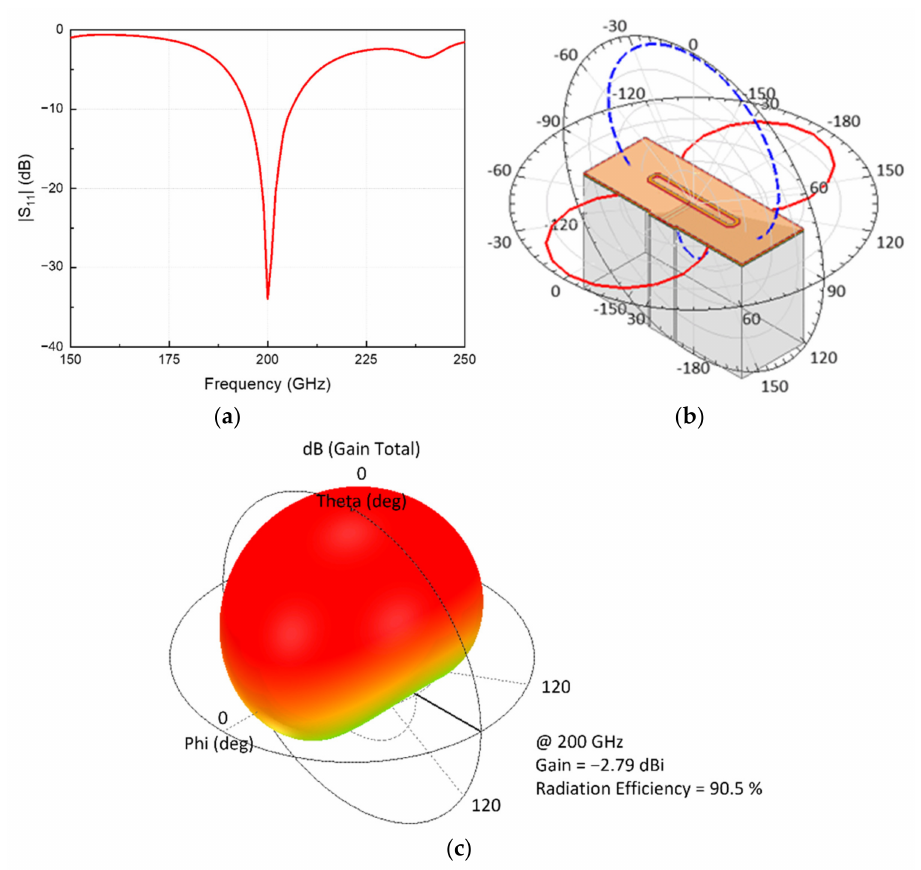
Figure 4. Simulation results of the integrated folded dipole antenna: ( a ) reflection coefficient |S 11 |; ( b ) far-field radiation pattern at 200 GHz; ( c ) 3D radiation pattern at 200 GHz.